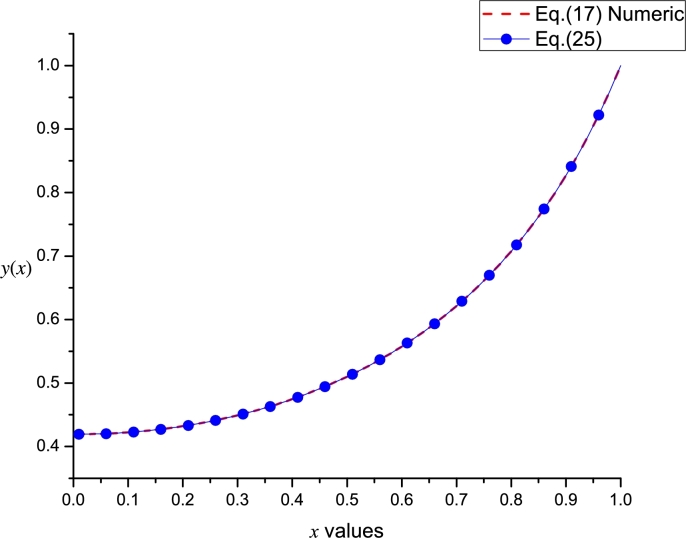
Comparison between numerical solution of (17) and (25).